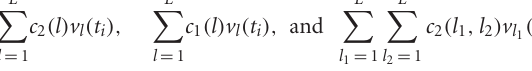
FIGURE 6 | The comparison between stimulation amplitude in RARIT that sent into CA1 and the amplitude calculated from inverse CA1 plant